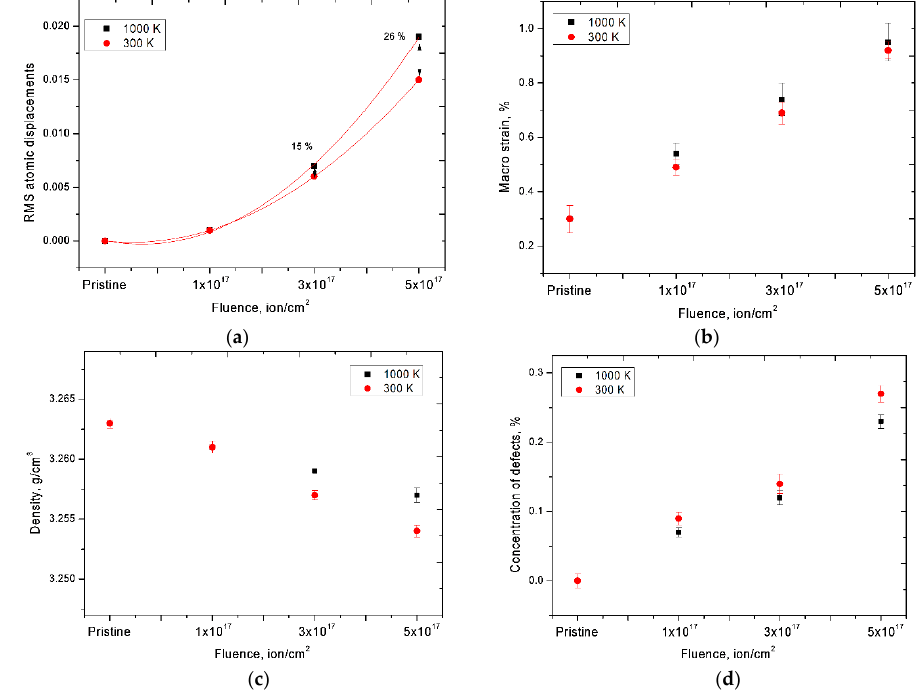
Figure 9. ( a ) Dynamics of change in the magnitude of atomic displacements from the lattice sites; ( b ) dynamics of changes in macrostress due to irradiation; ( c ) graph of the change in the density of ceramics as a result of irradiation; ( d ) dynamics of changes in the concentration of defects in the structure of ceramics.